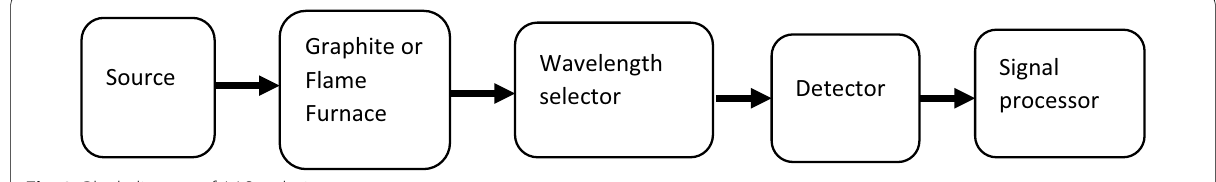
Fig. 2 Block diagram of AAS